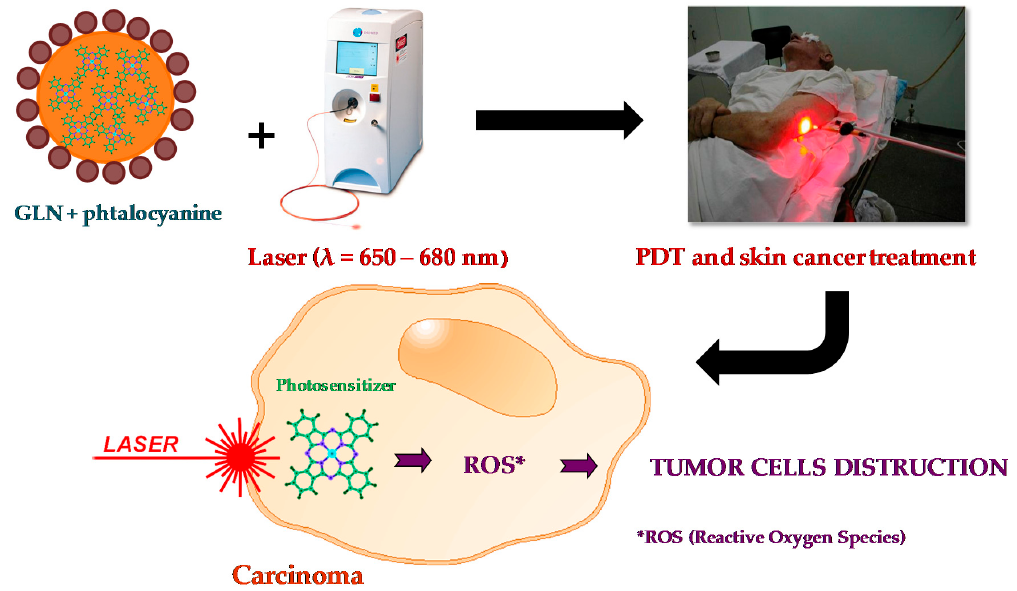
Figure 13. Representation of the medical treatment of skin cancers using photodynamic therapy (PDT). Authors have efficiently encapsulated ClAlPc (Figure 14a)—a second-generation